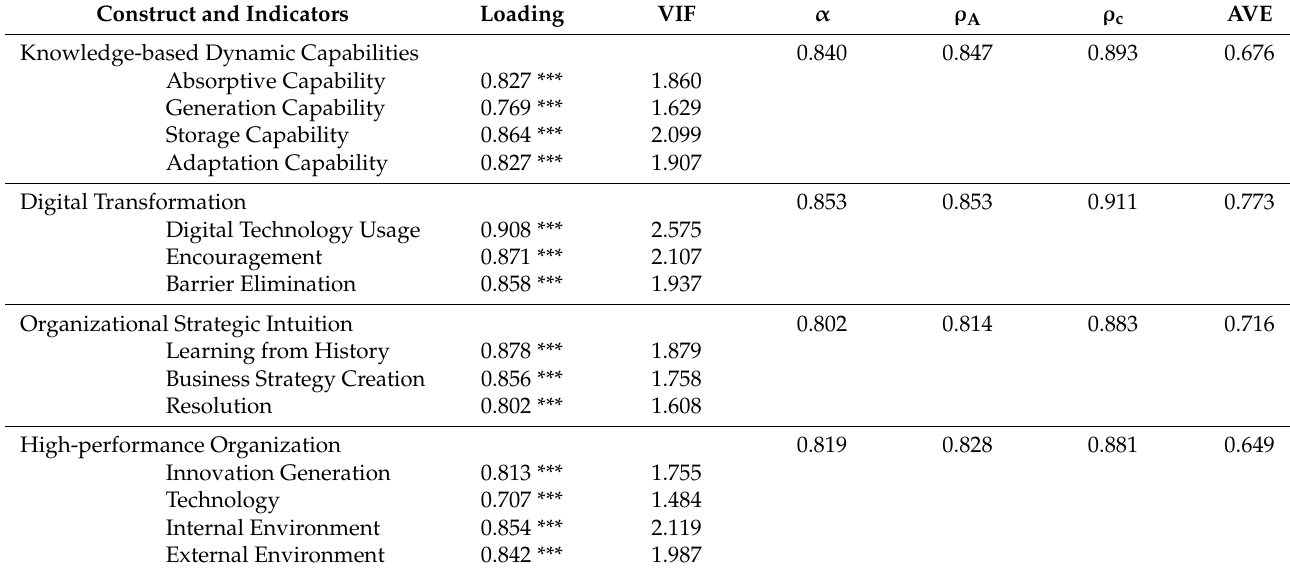
Table 3. Measurement model evaluation.